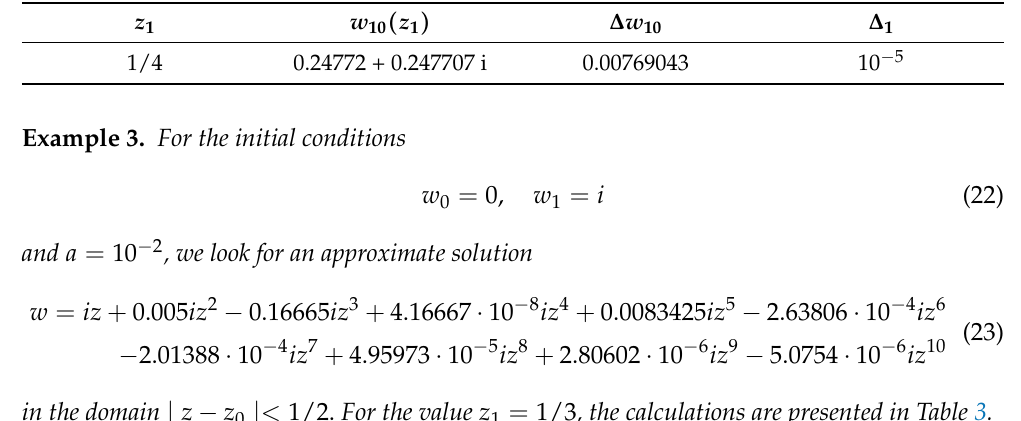
Table 2. Numerical characteristics of example